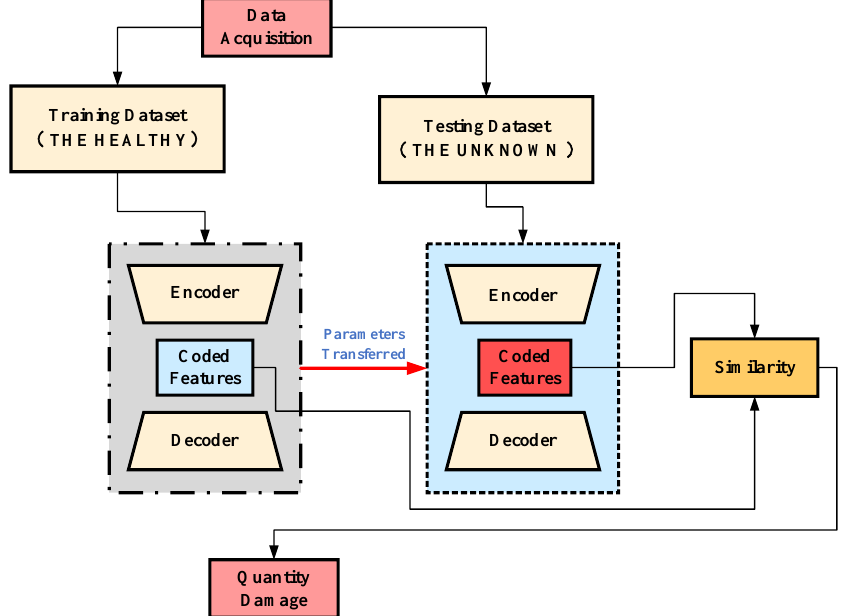
Figure 4. The MSCSA-AED based damage quantification framework.